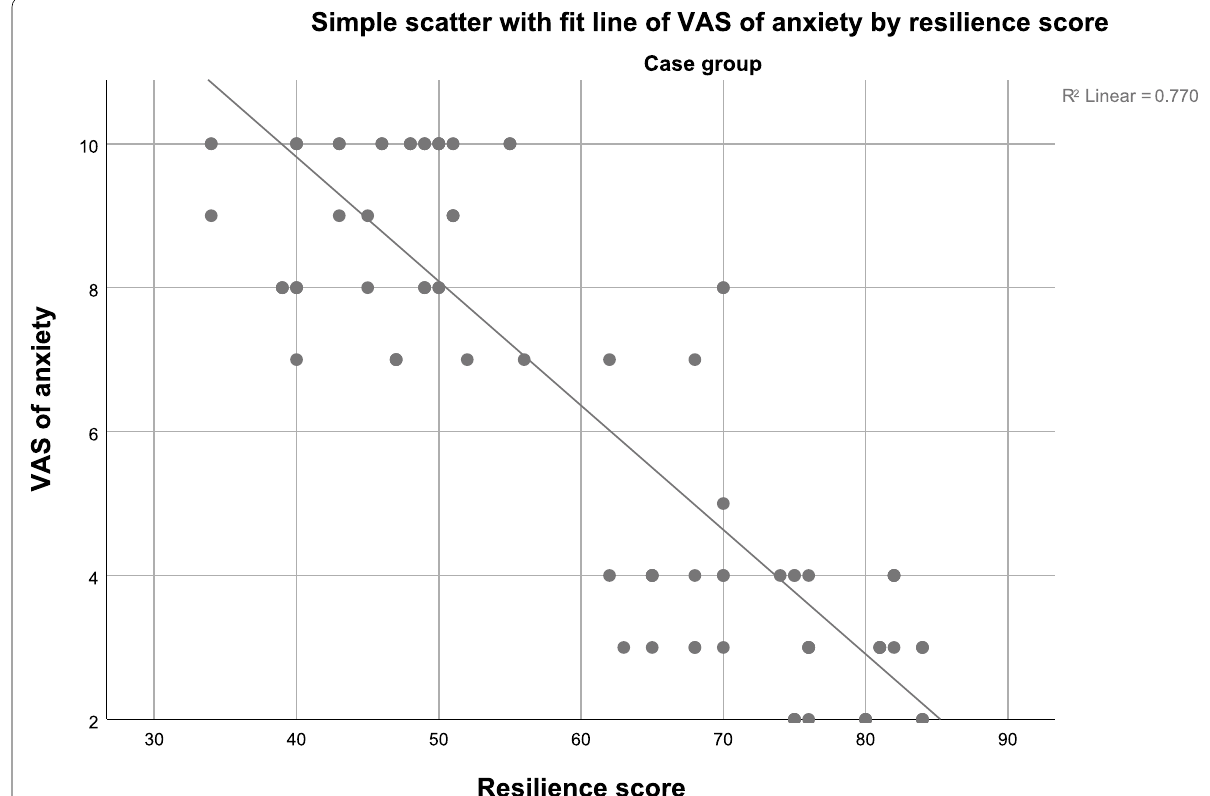
Fig. 5 Significant negative correlation of resilience with VAS of anxiety in fibromyalgia patients ( r